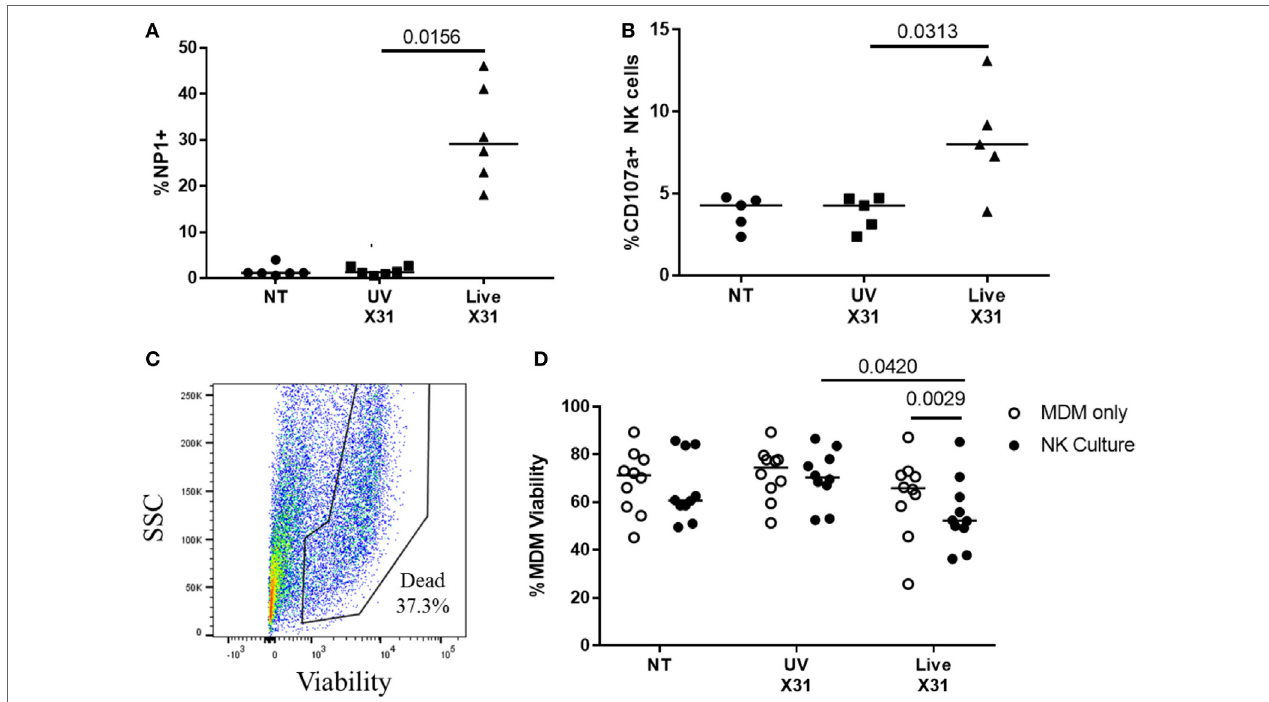
FigUre 9 | Peripheral blood natural killer (NK) cells are cytotoxic toward X31-infected cells. (a) X31 infection of monocyte-derived macrophages (MDMs) was determined by flow cytometric analysis of nucleoprotein-1 (NP1) expression ( N = 6). (B) Uninfected (NT), UV-irradiated X31, and live X31-infected MDMs were cultured with autologous peripheral blood NK cells for 4–6 h. NK cell degranulation was determined by flow cytometric analysis of surface CD107a ( N = 5). (c,D) Following culture with NK cells, MDM viability was measured by uptake of amine-binding dye and analyzed by flow cytometry ( N = 10). Representative gating for MDM viability. Fixable dead stain, viability gating defined through heat-killed control. (c) Representative gating of X31-infected MDM viability. Lines describe medians, statistical analysis by Wilcoxon signed-rank test.